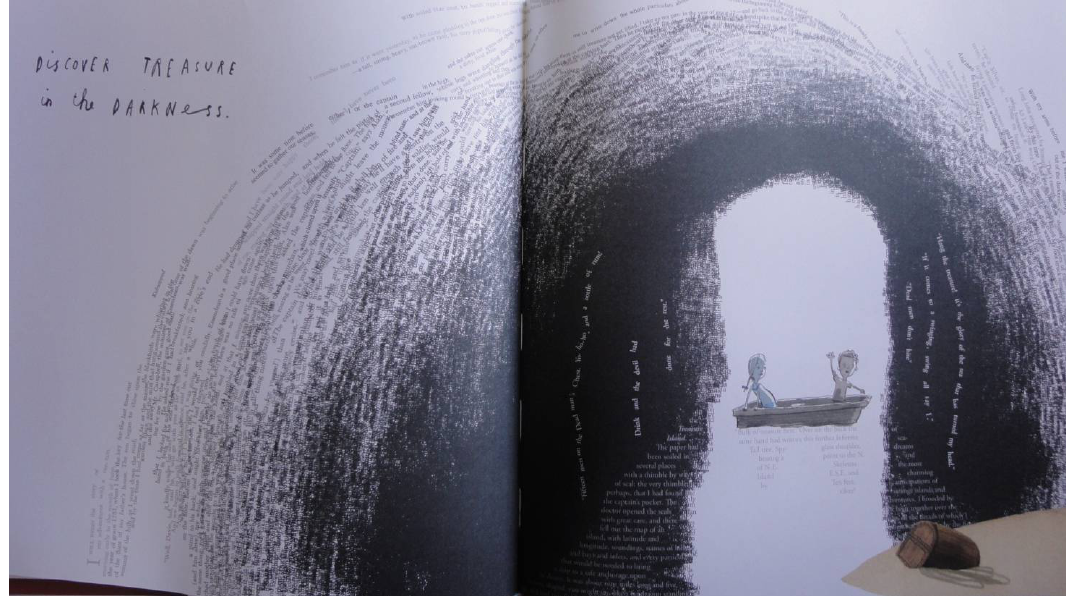
Figure A16. Jeffers O.; Winston S. A child of books, Walker Books, London, 2016.